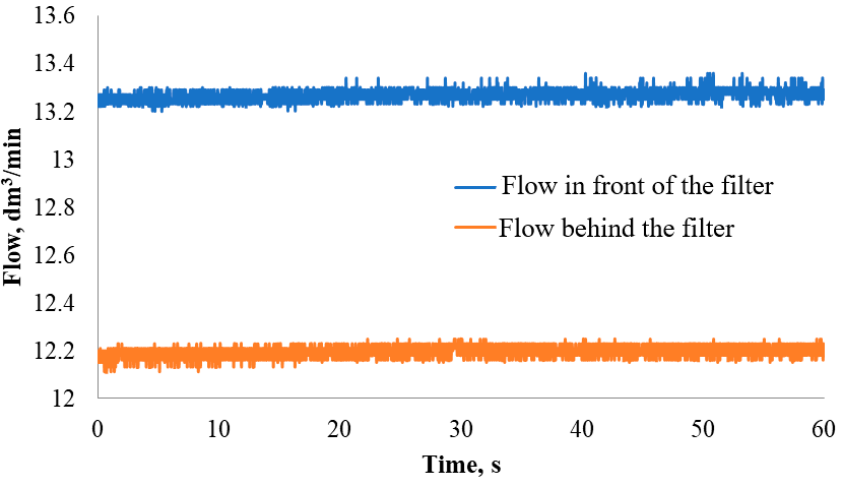
Figure 6. Plot of flow of uncontaminated oil with CNH Industrial 2992242 filter at 30 °C.